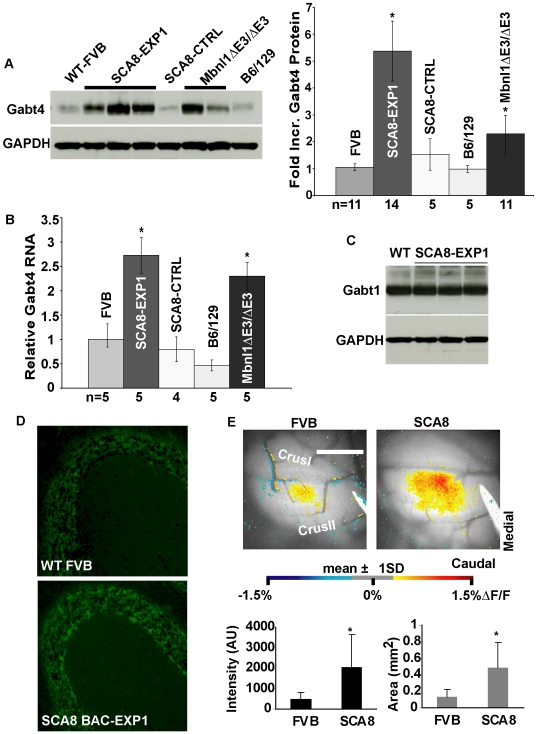
Upregulation of Gabt4 in SCA8 BAC-EXP1 and Mbnl1
ΔE3/ΔE3 mice.(A) Example immunoblot showing increase in Gabt4 protein in SCA8 BAC-EXP1 and Mbnl1ΔE3/ΔE3 mice relative to strain specific WT controls. Bar graph shows average Gabt4 protein quantified by densitometry methods, and analyzed for mean between group differences compared to strain specific wild type animals. Asterisks = significant differences for SCA8 (p<0.002) and Mbnl1ΔE3/ΔE3 (p<0.001) mice compared to non-transgenic controls. (B) qRT-PCR showing increased Gabt4 vs. Hprt in SCA8 BAC-EXP and Mbnl1
ΔE3/ΔE3 compared to BAC-CTRL and non-transgenic littermates. Asterisks = statistical significance, p = 0.0015 for SCA8 and p<0.01 for Mbnl1
ΔE3/ΔE3 mice compared to non-transgenic controls. (C) Example protein blot showing no change in another prominent cerebellar GABA transporter receptor, Gabt1, in SCA8 BAC-EXP1 mice. (D) Fluorescent IHC staining showing a similar distribution with a qualitative increase in Gabt4 IF in cerebellar granular cell layer in SCA8 BAC-EXP1 compared to wildtype mice. (E) Optical responses in Crus II to stimulation of the ipsilateral C3 whisker pad in FVB and SCA8 mice showing increased cerebellar cortical response to whisker pad stimulation in SCA8 mice. Shown are the thresholded (mean±1 SD of the control region) and pseudocolored responses superimposed on an image of the background fluorescence. Scale bar = 1 mm. Both the intensity and area of the responses were greater in the SCA8 mice compared with FVB control mice. *denotes p<0.05.